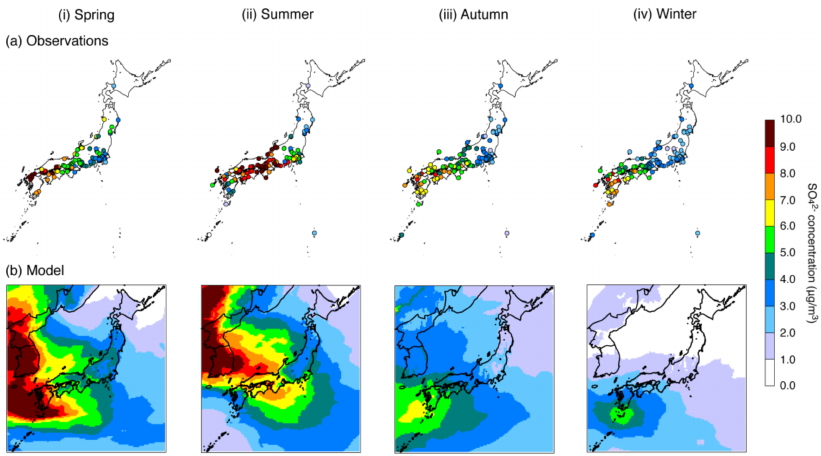
Figure 2. Spatial distribution of SO 42 − concentration from ( a ) observations and ( b ) the model averaged over ( i ) spring, ( ii ) summer, ( iii ) autumn, and ( iv ) winter. Model results are from the base-case simulation.